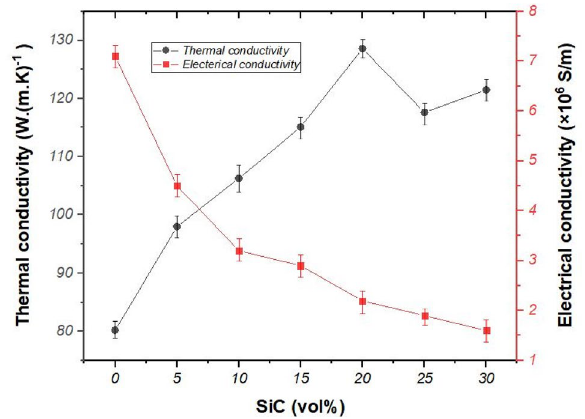
Figure 7. The variation of electrical and thermal conductivity of in situ HfB 2 –SiC composites.